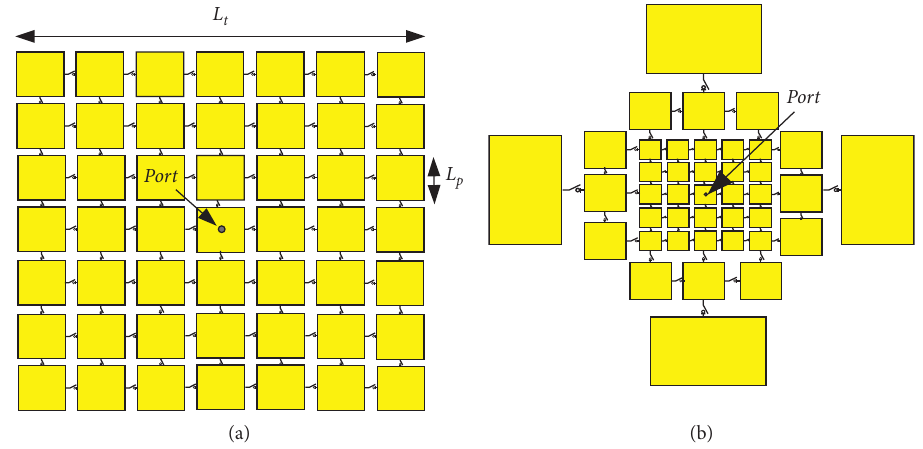
Figure 1: Schematic diagram of pixel antenna: (a) uniform pixel antenna; (b) multisize pixel antenna.